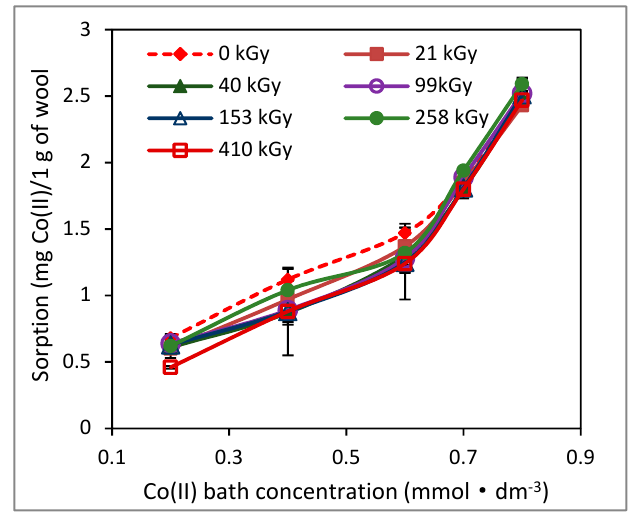
Figure 7. Variation of Co(II) sorption on wool with different absorbed dose depending on Co(II) concentration in bath after 102 days from irradiation.